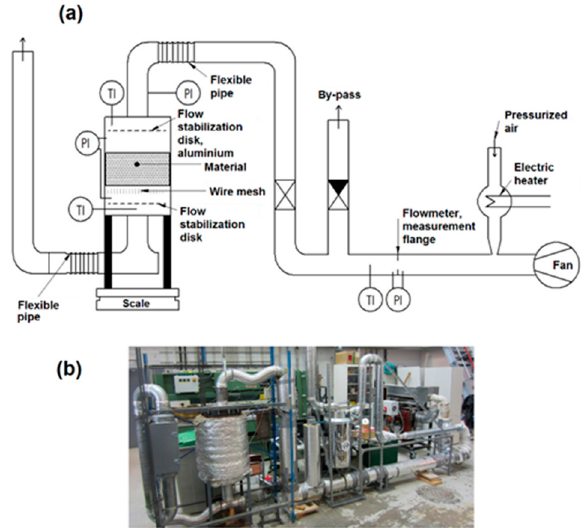
Figure 2. Test rig used in the tests: ( a ) Flow diagram of the equipment, and ( b ) The test rig in the